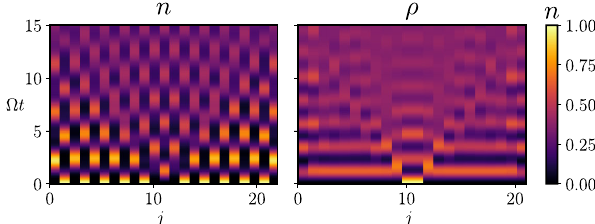
FIG. 6. Propagation of a particle-antiparticle pair q − ¯ q with realistic Rydberg interactions. Left-hand panel: Density of Rydberg excitations. Right-hand panel: Density of particles or antiparticles ( ρ in the QLM language). Results are obtained for a chain of L ¼ 23 sites governed by the realistic Hamiltonian Eq. (1) with V ij ¼ V 1 j i − j j − 6 and no constraints in the Hilbert space. Parameters are δ ¼ 0 , V 1 = Ω ¼ 25 . 6 . We checked explic- itly that the violation of Rydberg blockade is always small, with i < 10 − 2 h n j n j þ 1